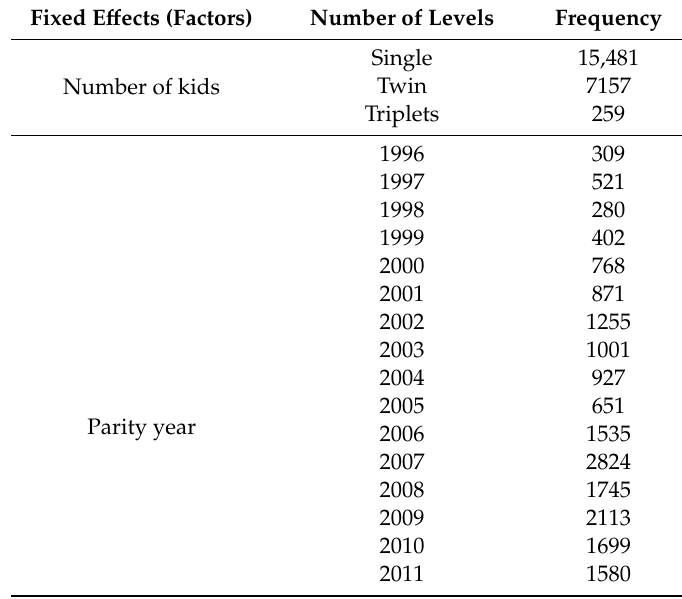
Table 2. Number of lactations per number of kids, year and